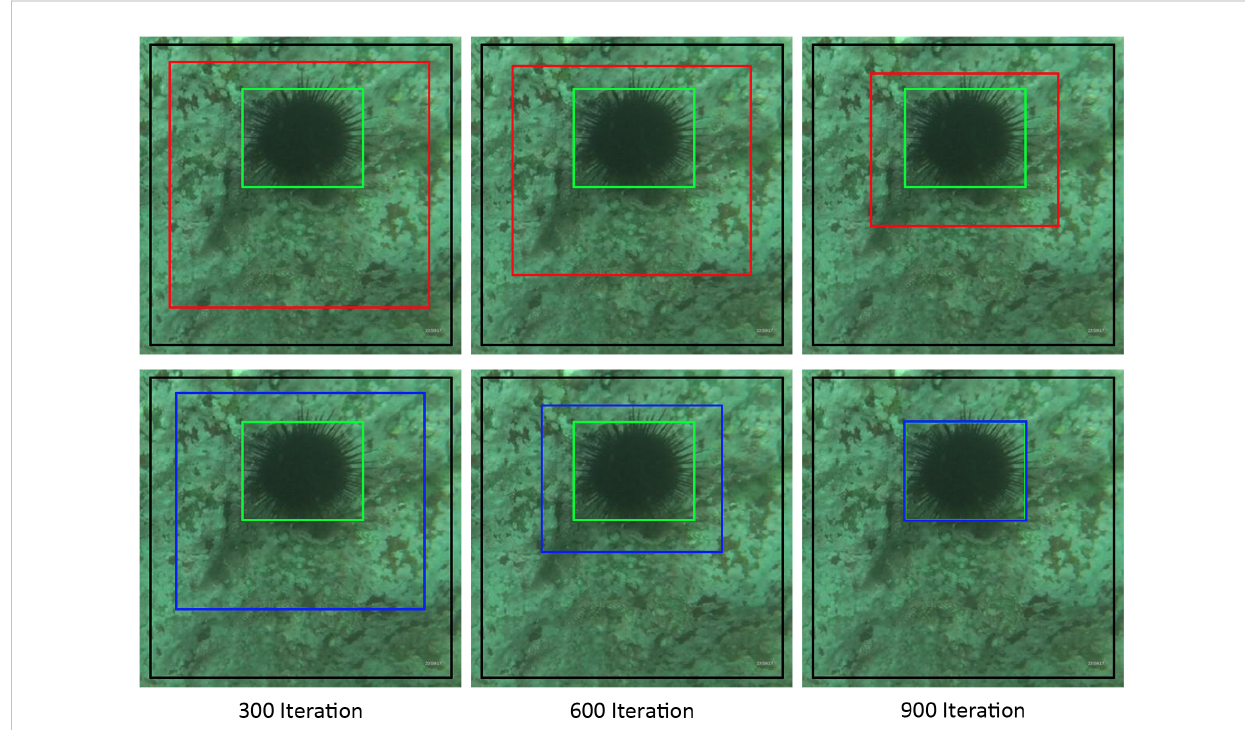
FIGURE 6 The diagrams of prediction box regression in the fi rst and second row respectively represent the prediction box regression process of CIoU and FIoU. The green box refers to the ground truth box. The black box refers to the anchor box, and the red and blue one is the prediction boxes of CIoU and FIoU, respectively.